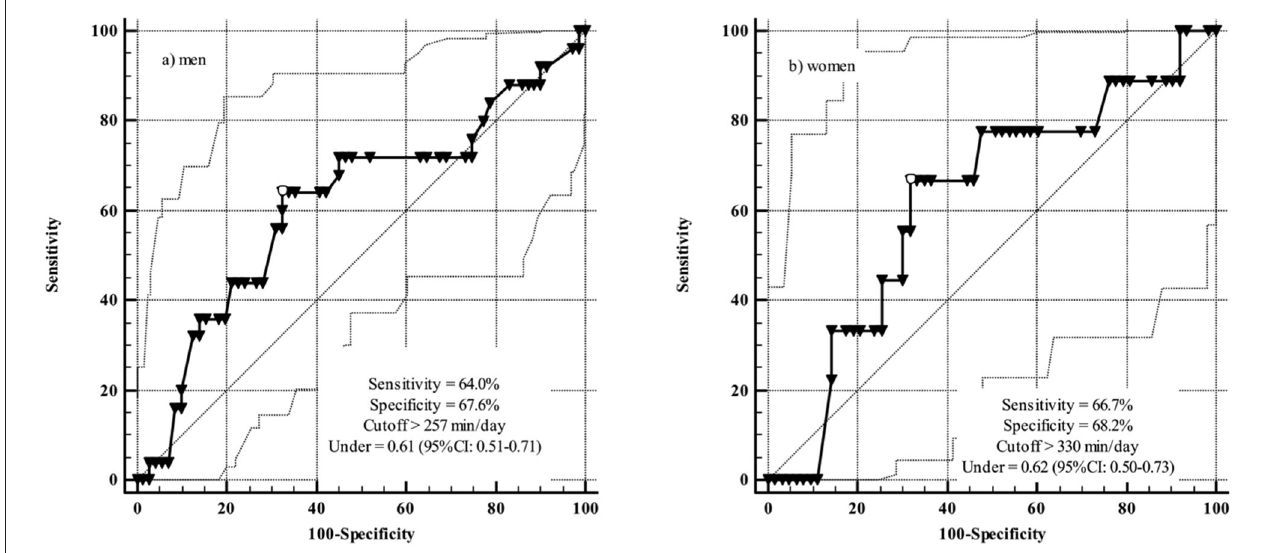
FIGURE 1 | Sitting time cut-points for discriminating frailty in older